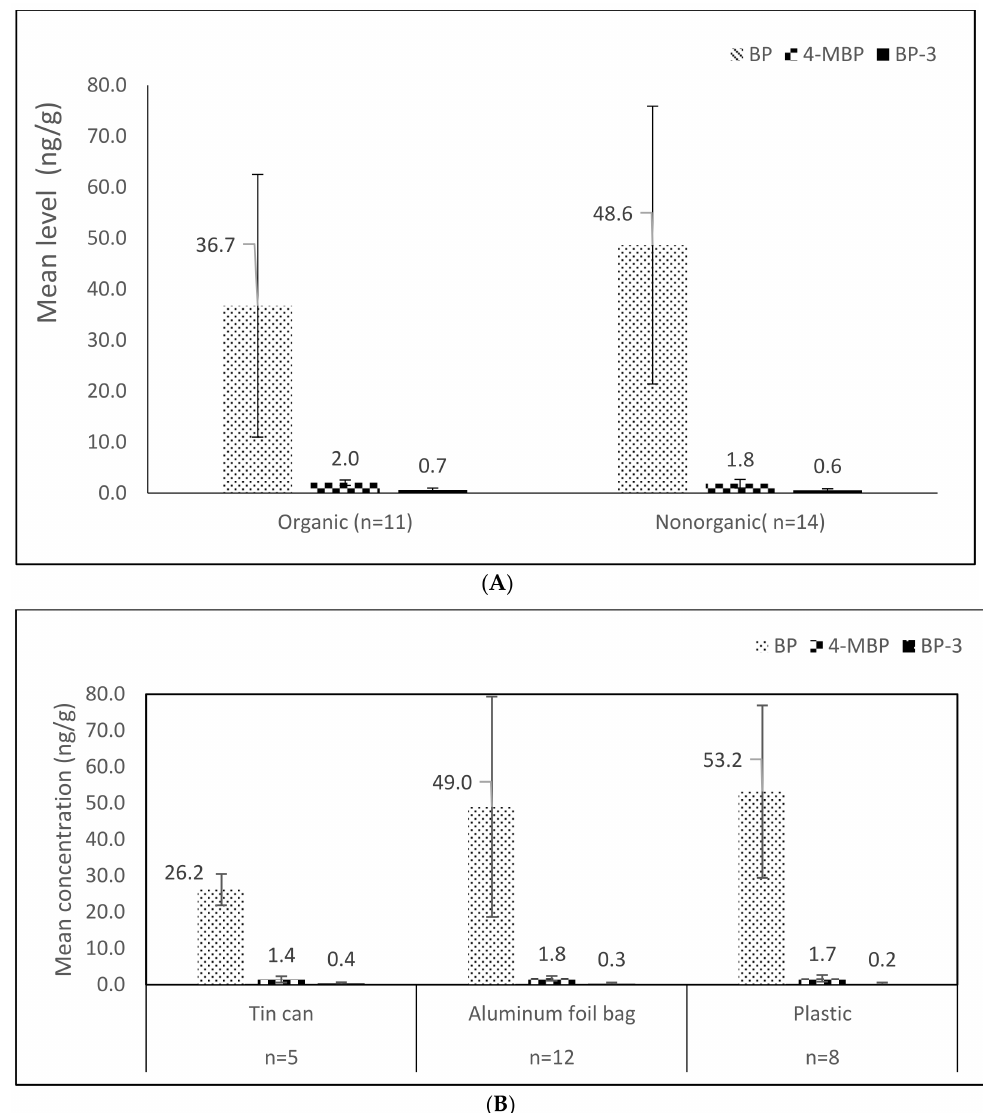
Figure 4. BP, 4-MBP, and BP-3 levels grouped by ( A ) chemical nature and ( B ) packaging materials in rice